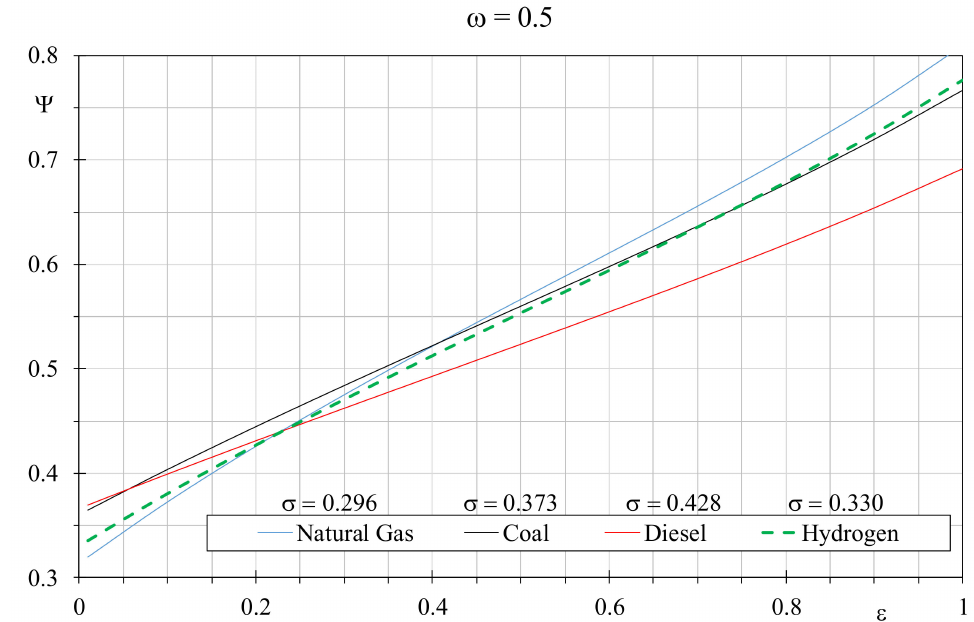
Figure 4. Comparison of the Environmental Quality Index (EQI) related to the boiler heat exchanger efficiency for the considered fuels, with different value of the dimensionless temperature factor and by setting ω = 0.5.